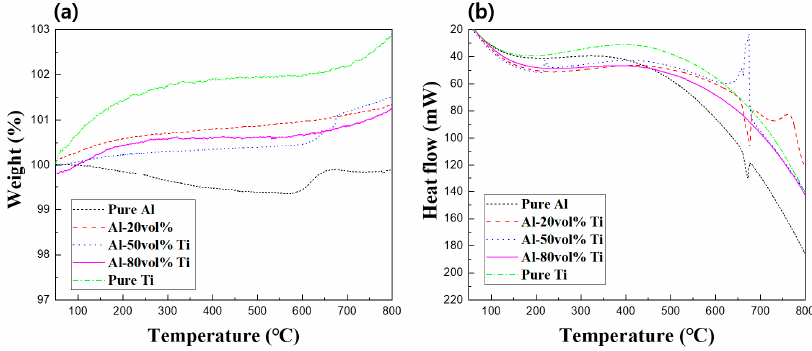
Figure 7. ( a ) TGA and ( b ) DTA curves of pure Al and Ti and Al-20, 50, and 80 vol.% Ti composites.